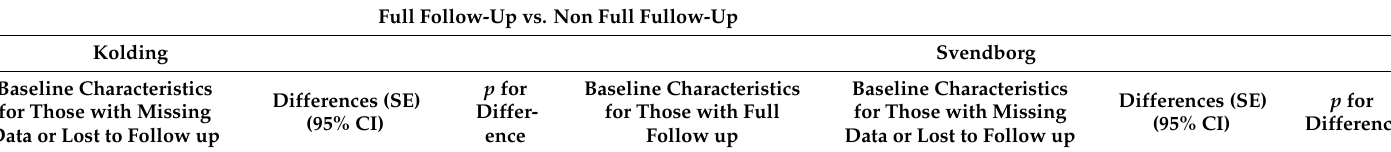
Table 2. Comparison of baseline characteristics for those with follow up and those with non-full follow up. Normally distributed data is presented with mean (sd) (95% CI) and n. Non-normally distributed data is presented with medians (95% CI) and n, or with percentages. Between group differences are presented as crude values with (95% CI) or percentages an p -values. * The star denotes between group differences in non-normally distributed